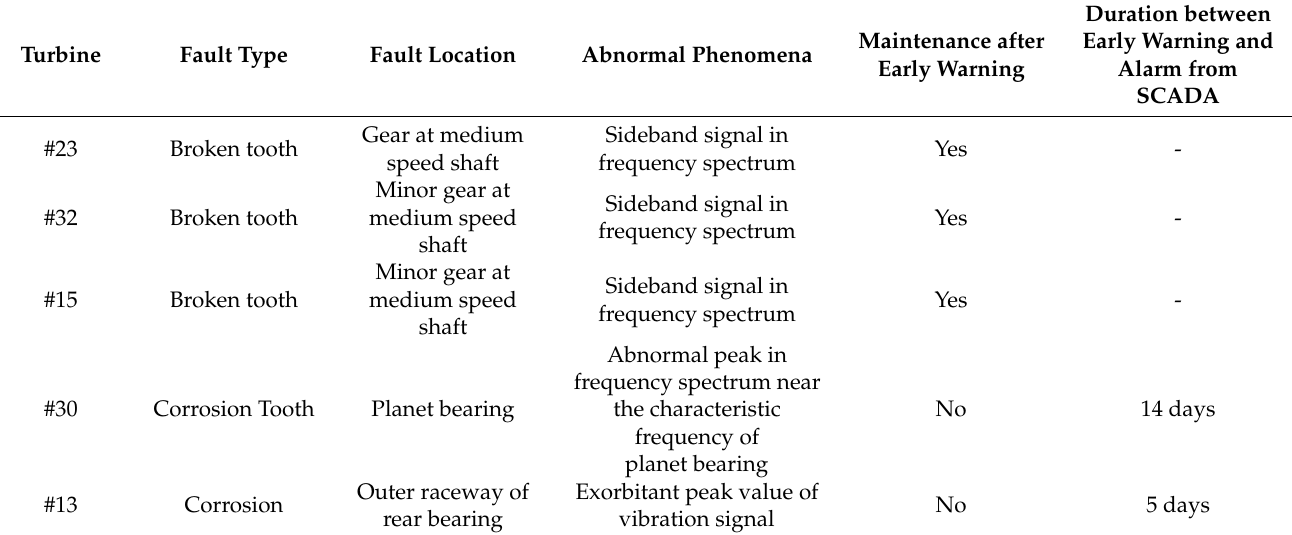
Table 2. Results of diagnoses of to typical faults in wind turbine main drive